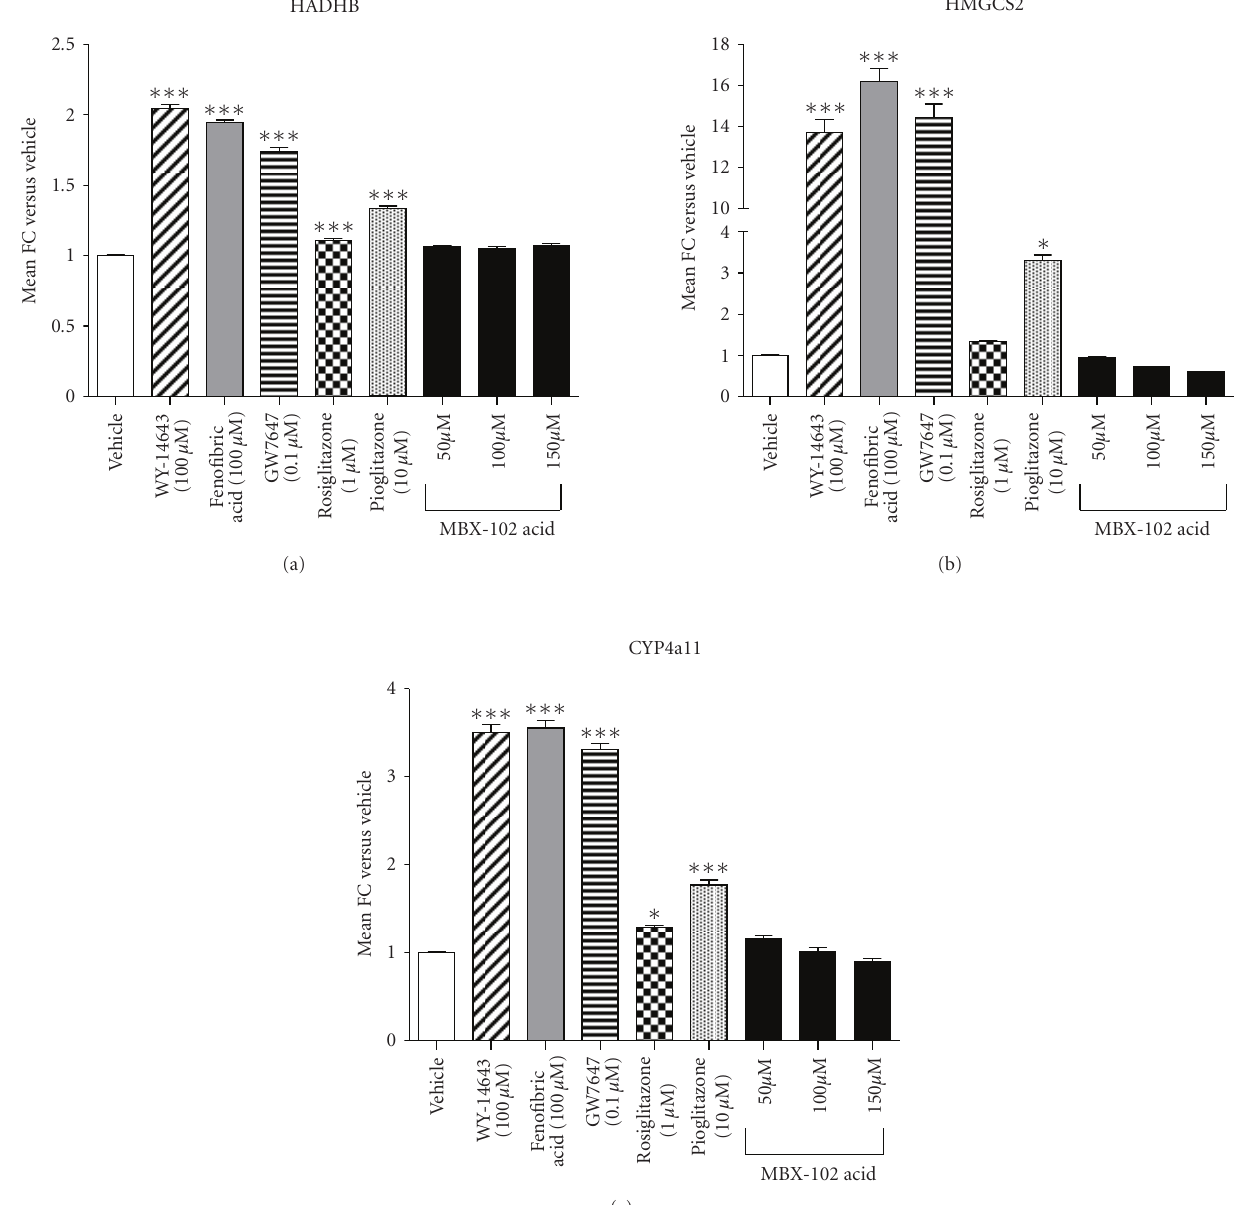
Figure 7: E ff ect of PPAR- α agonists, rosiglitazone, pioglitazone, and MBX-102 acid on HADHB (a), HMGCS2 (b), and CYP4a11 (c) mRNA levels in primary human hepatocytes. Values represent mean ± SEM ( ∗ : P < . 05, ∗∗∗ : P < . 001 versus Vehicle-treated, 1-way ANOVA and Tukey’s multiple comparison